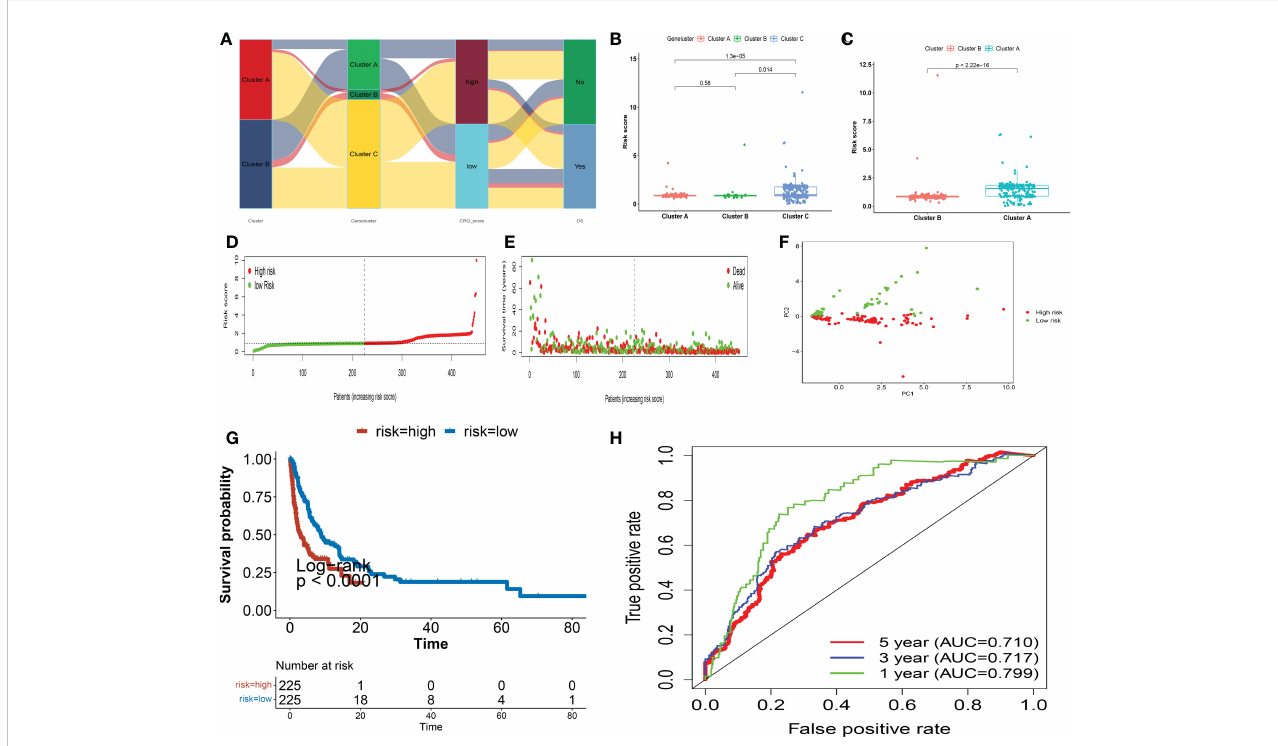
FIGURE 6 In the training set, the CRG score is constructed. (A) An alluvial diagram depicting subgroup distributions in groups with varying CRG scores and survival outcomes. (B) CRG score differences between gene subgroups. (C) CRG score differences between cuprotosis subgroups. (D, E) Dot and scatter plots display the distribution of CRG scores and patient survival status. (F) Prognostic signature-based PCA analysis. Patients at high and low risk are represented by red and steel blue dots, respectively. (G) Kaplan Meier analysis of the OS between the two groups. (H) ROC curves to predict the sensitivity and speci fi city of 1-, 3-, and 5-year survival according to the CRG score. PCA, principal component analysis; OS, overall survival; ROC, receiver operating